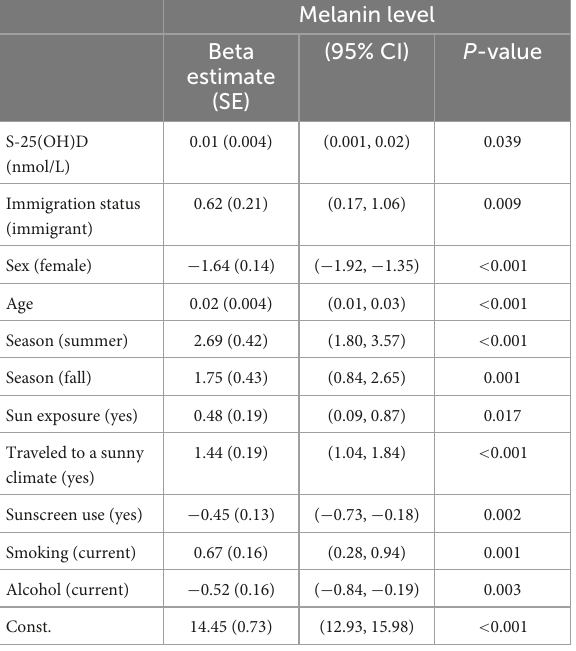
TABLE 4 Multivariable linear regression analysis based on melanin and immigration status using Cycles 3 and 4 of Canadian Health Measures Survey (CHMS)